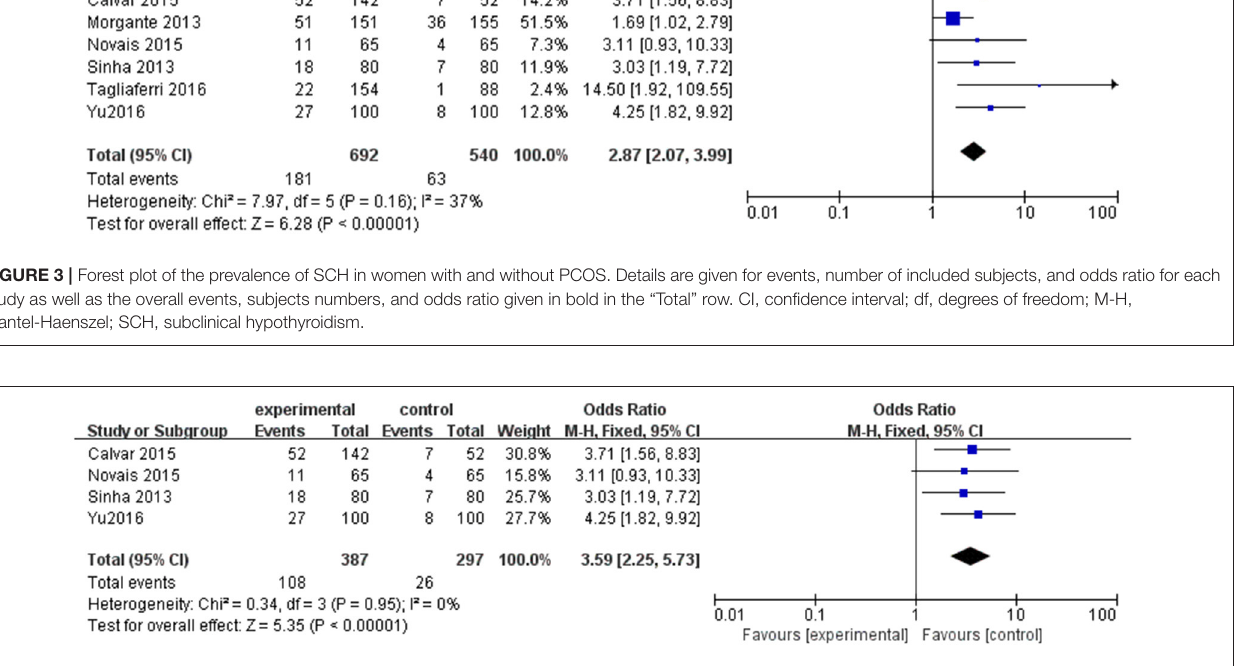
FIGURE 4 | Subgroup analysis for SCH and PCOS when TSH cut off is higher than 4.0 mIU/mL. Details are given for events, number of included subjects, and odds ratio for each study as well as the overall events, subjects numbers, and odds ratio given in bold in the “Total” row. CI, confidence interval; df, degrees of freedom; M-H, Mantel-Haenszel; SCH, subclinical